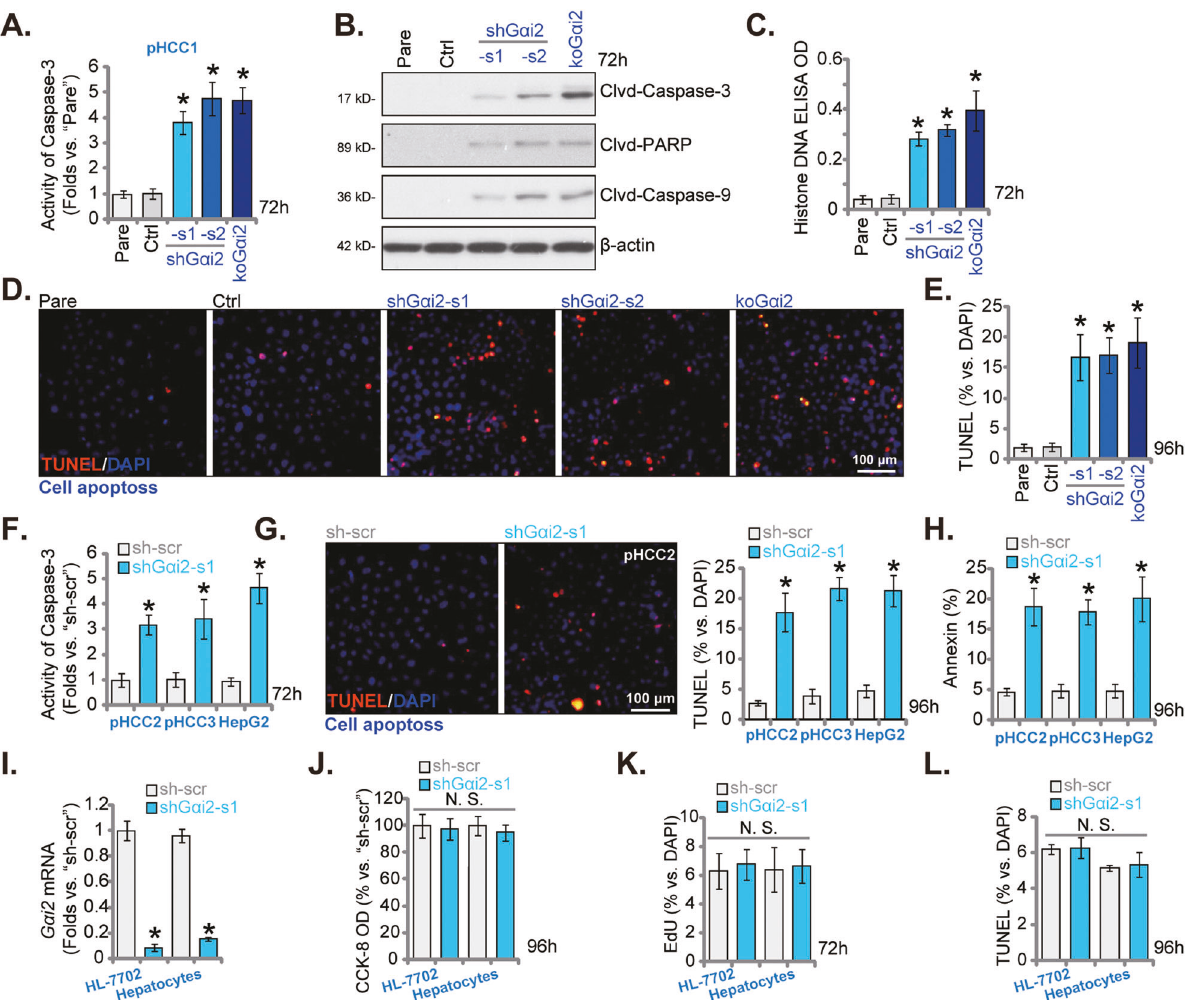
medium and cultivated for indicated time periods, the relative Caspase-3 activity ( A ), expression of the apoptosis-associated proteins ( B ) and Histone-bound DNA contents ( C ) were tested; Cell apoptosis was evaluated by measuring the percentages of TUNEL-positive nuclei ( D , E ). The control cells ( “ Ctrl ” ) were stably transduced with scramble control shRNA (sh-scr) plus lenti-CRISPR/dCas9-puro construct. The exact same amount of viable pHCC2 and pHCC3 primary cells or immortalized HepG2 cells, expressing the lentiviral shG α i2-s1or sh-scr, were cultured for indicated time periods, the relative Caspase-3 activity ( F ), the percentages of TUNEL-positive nuclei (% vs. DAPI) ( G ) and Annexin V-positive cells ( H ) were measured. Expression of G α i2 in HL-7702 hepatocytes or the primary human adult hepatocytes ( “ Hepatocytes ” ) with shG α i2-s1or “ sh-scr ” was shown ( I ); The hepatocytes were further cultivated for indicated time periods, cell viability, proliferation and apoptosis were measured by CCK-8 ( J ), nuclear EdU staining ( K ) and TUNEL staining ( L ) assays, respectively, with results quanti fi ed. “ Pare ” stands for